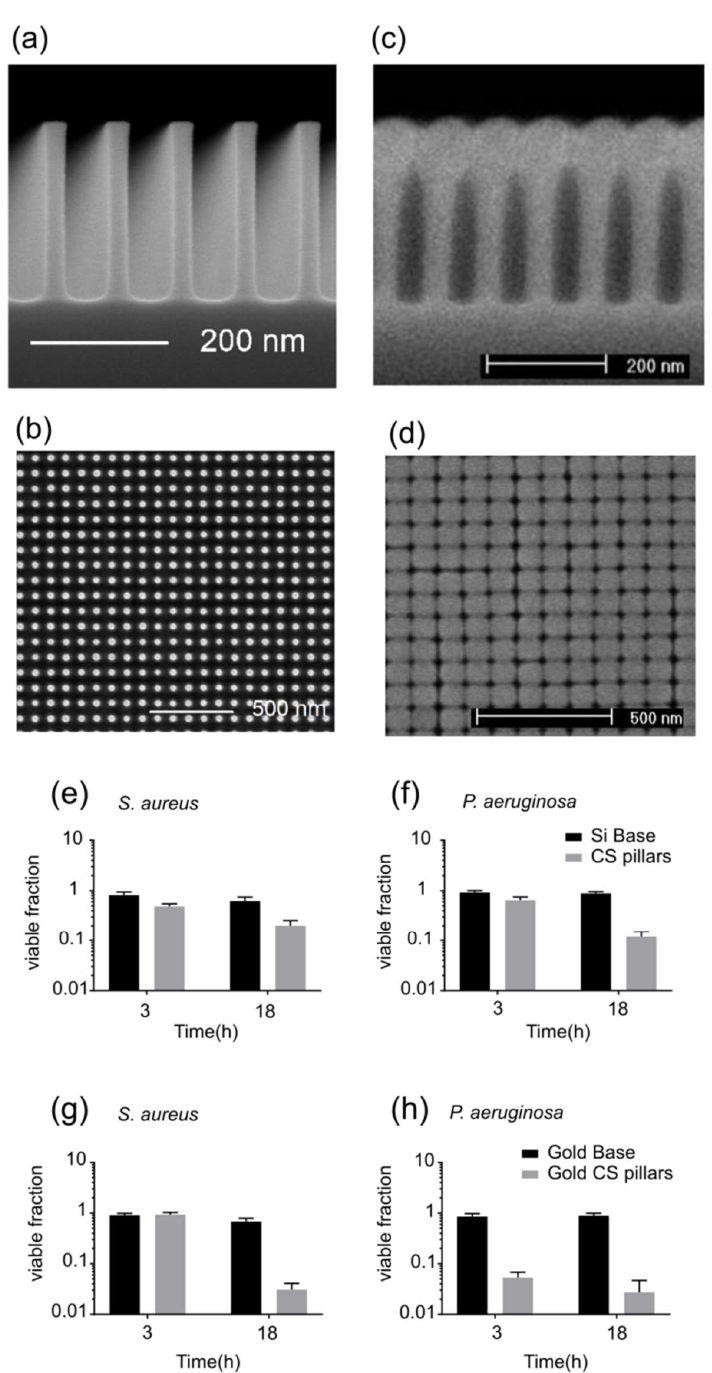
Figure 1. Surface topology of silicon-based cotton swab (CS) nanopillars and their bactericidal activity. ( a – b ) Electron micrographs show ( a ) the side-view and ( b ) the top-view of highly ordered 260 nm tall silicon nanopillars. ( c ) SEM side-view of the cotton swab (CS)-shaped nanopillars achieved by sputter coating silicon (100 nm thickness) on the nanopillars shown in ( a ) and ( b ). ( d ) SEM top-view of the CS nanopillars. ( e – f ) Plots show the fraction of ( e ) Staphylococcus aureus and ( f ) Pseudomonas aeruginosa cells that survived 3 and 18 h of incubation on top of the control surface (silicon base substrate) and the surface with CS nanopillars. ( g – h ) Plots show the fraction of ( g ) S. aureus and ( h ) P. aeruginosa cells that survived 3 and 18 h of incubation on top of the control surface (100 nm gold-coated silicon base substrate) and the surface with gold CS pillars (100 nm thickness). Viable fraction was measured by plating and colony-forming unit (CFU) counting.